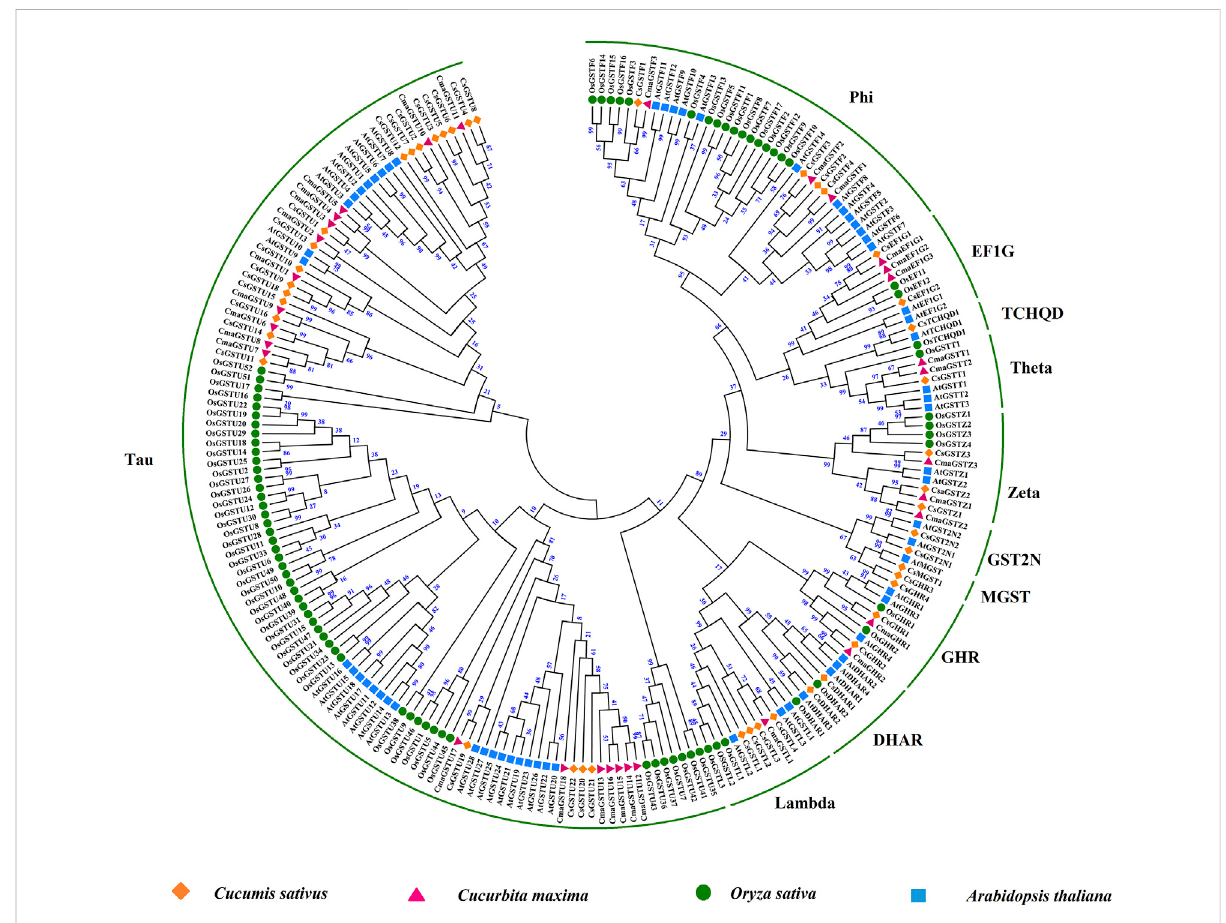
FIGURE 3 Phylogenetic analysisof GST proteins from differentspecies. Phylogenyof theGST proteins from cucumber rice,pumpkin, and A.thaliana .The number on each node represents bootstrap values. The GST proteins of cucumber are divided into 11